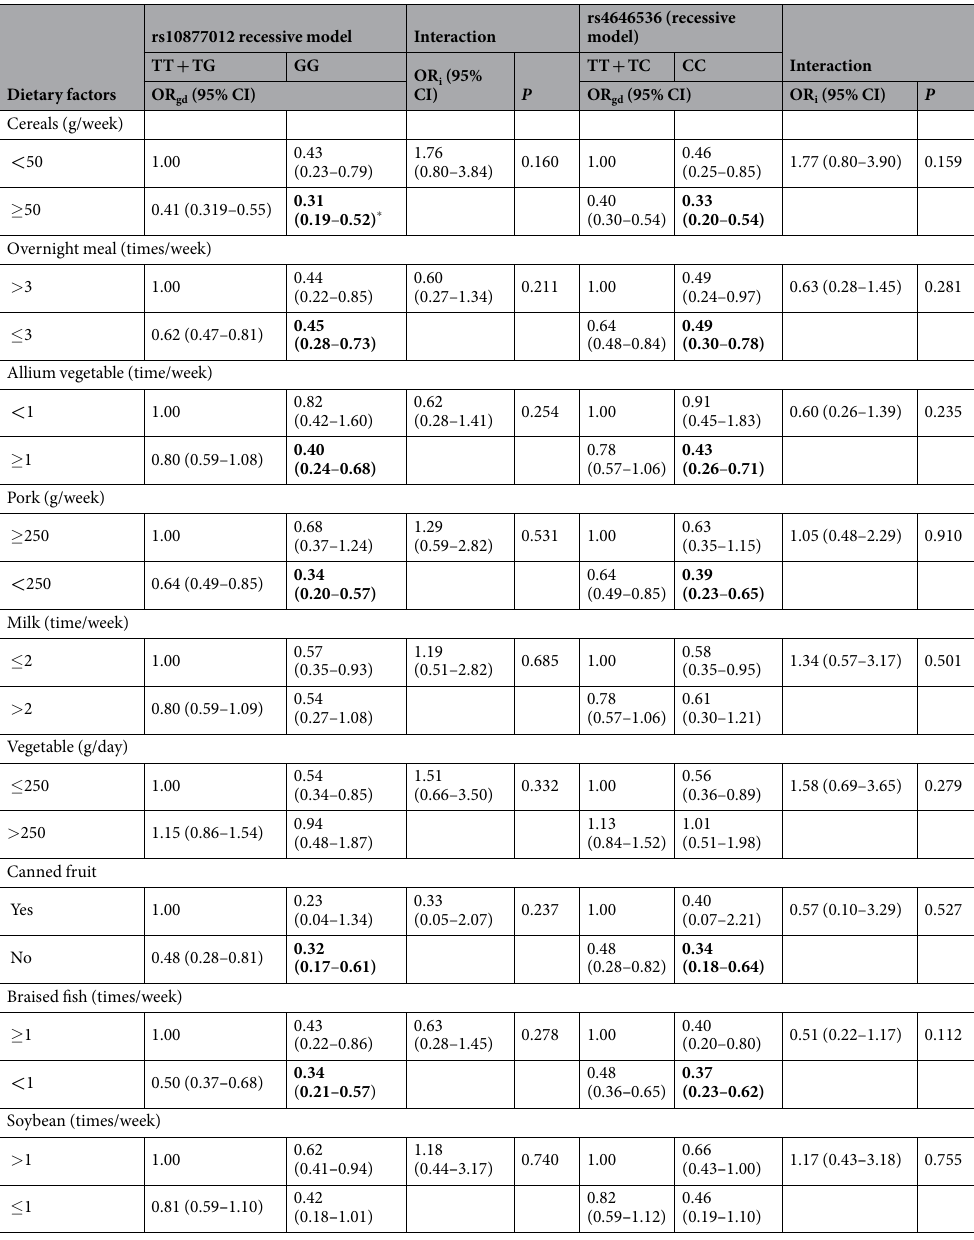
There is a paucity of information on the associations of clinical characteristics and 25-OHD level or poly- morphisms in genes related to vitamin D metabolism. Four published studies on patients with CRC reported better overall survival among those with higher 25(OH)D 3 levels than those with lower levels 45–48 . miRNAs are